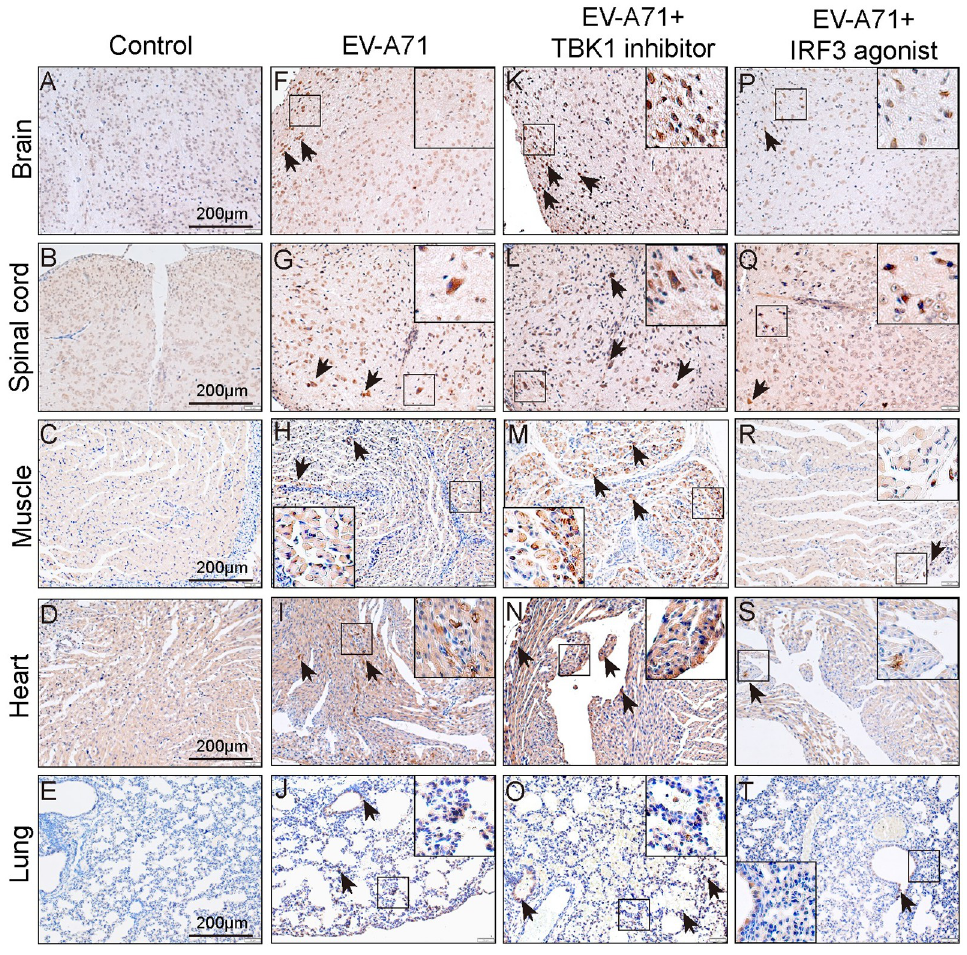
Fig 3. TBK1 and IRF3 interventions on the antiviral activity against EV-A71 in mice. The brains ( A, F, K, P ), spinal cords ( B, G, L, Q ), muscles ( C, H, M, R ), hearts ( D, I, N, S ) and lungs ( E, J, O, T ) of mice were dissected for immunohistochemical analysis at 5 dpi. The black arrows indicated the positive staining (brown) and pictures were captured using an inverted fluorescence microscope. Bar = 200 μ m. n = 4 per group, all experiments were repeated three